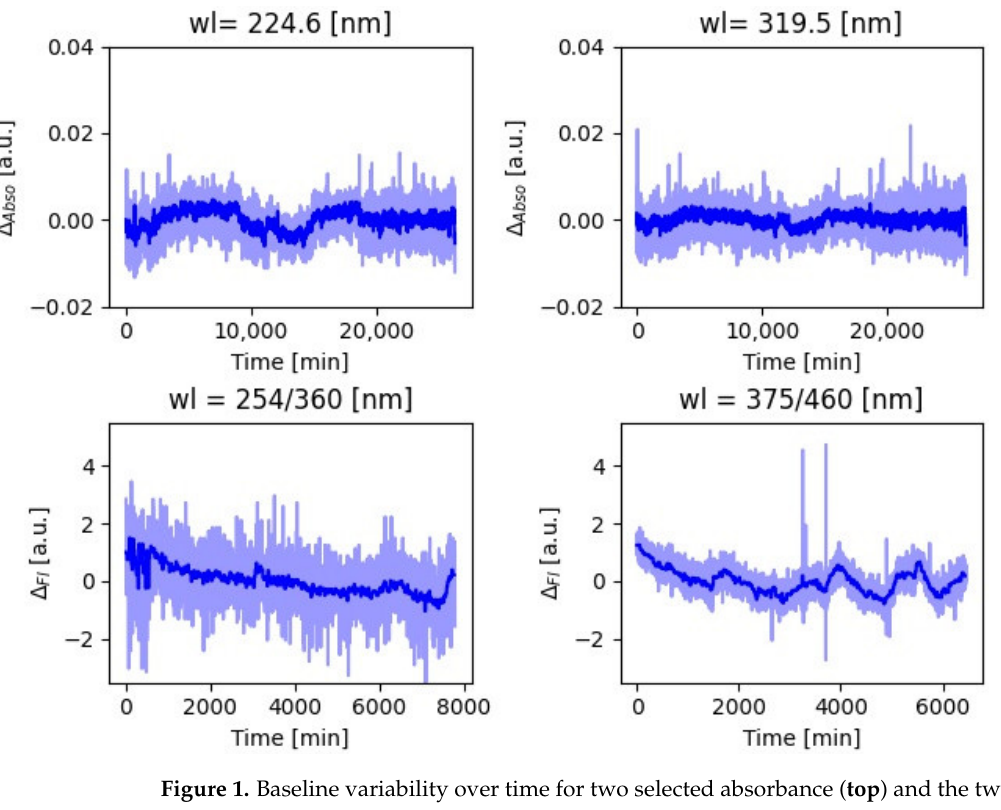
Figure 1. Baseline variability over time for two selected absorbance ( top ) and the two fluorescence ( bottom ) wavelengths at specific wavelength. Light blue shows raw data while dark blue shows data average over 10 min intervals.